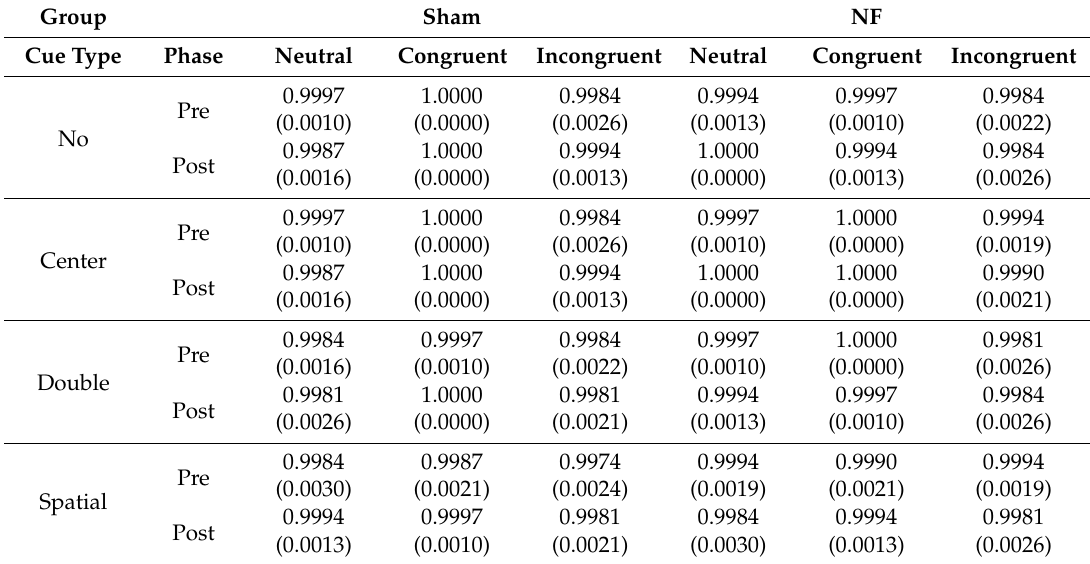
Table 5. Mean RTs (standard deviations) according to cue and flanker types for each